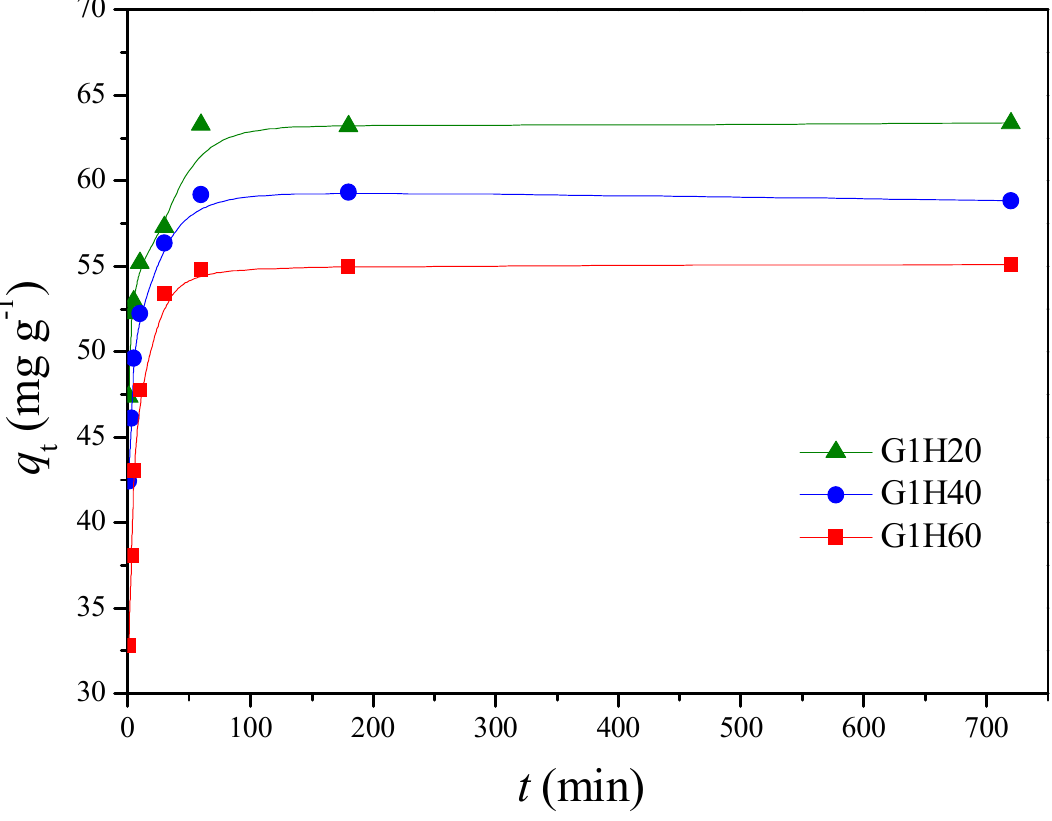
Figure 4. Comparison of Cu(II) adsorption onto PGA-AP nanoparticles with different weight ratios of γ-PGA to AP at a pH of 6 and 30 °C.